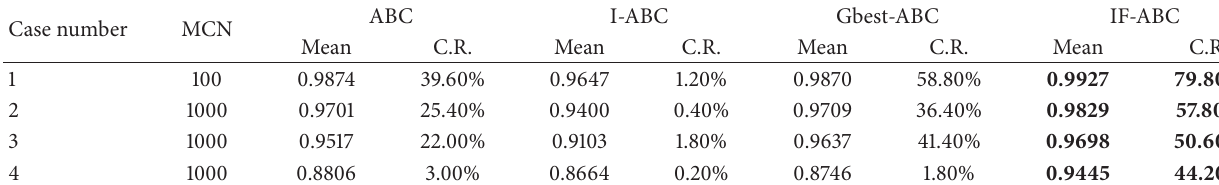
Table 2: Comparative convergence performances of four ABCs.